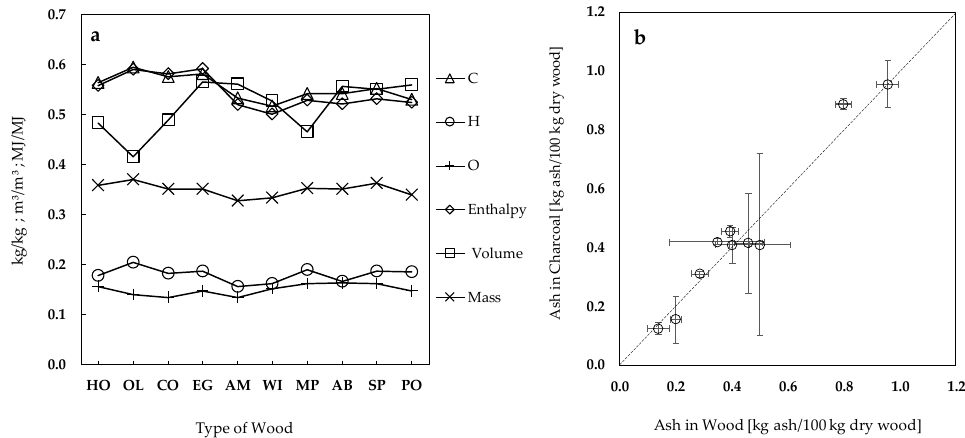
Figure 4. Quantities of ( a ) main elements (C, H, O), enthalpy, volume, total mass, and ( b ) ash remaining in the charcoal particles in relation to the respective quantities initially present in the dry wood particles, during experiments conducted at 1 °C/min and final temperature of 400 °C. Wood abbreviations according to legend in Figure 2.